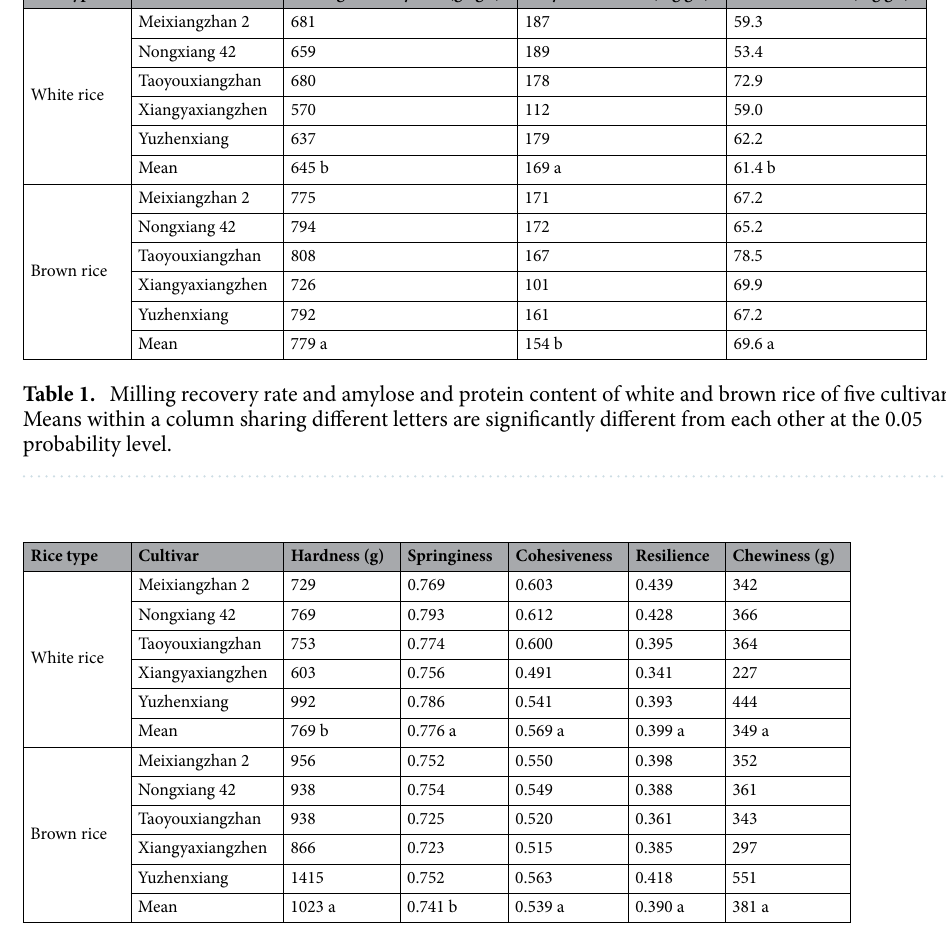
Table 2. Texture profiles of cooked white and brown rice of five cultivars. Means within a column sharing different letters are significantly different from each other at the 0.05 probability level.